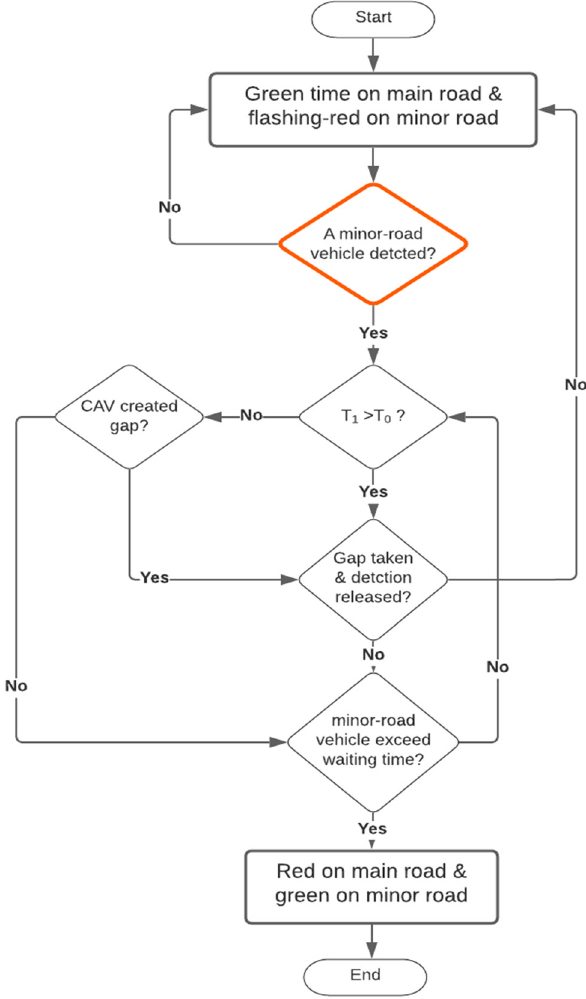
Figure 10: Control logic for semi - actuated signal